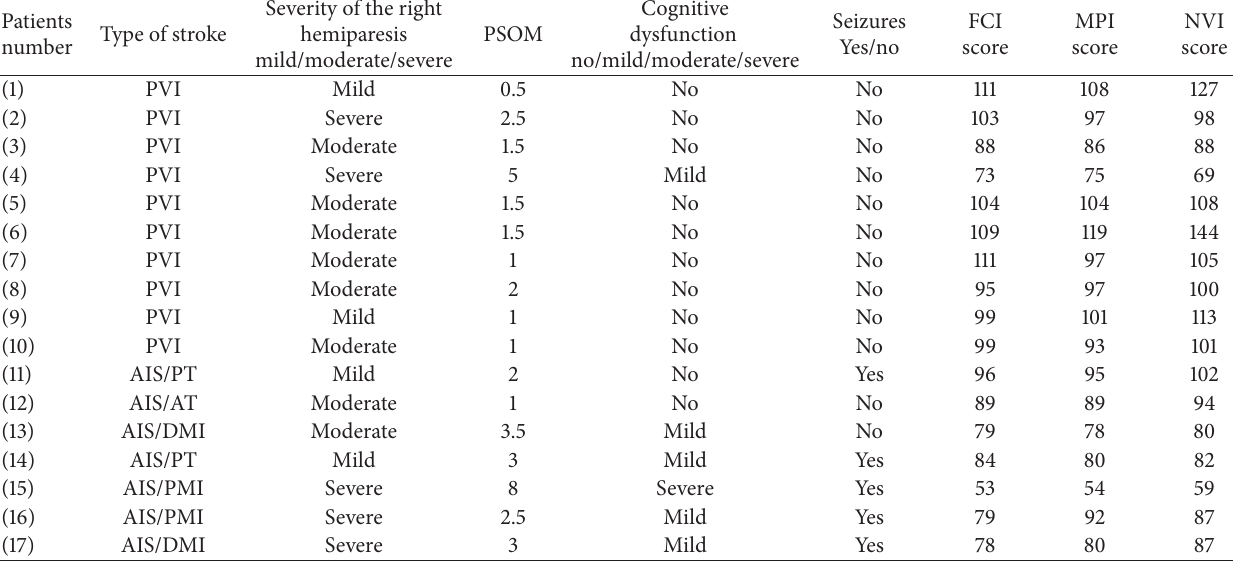
Table 2: Clinical data and data of cognitive function for the children with periventricular venous infarction and arterial ischemic stroke. Patients